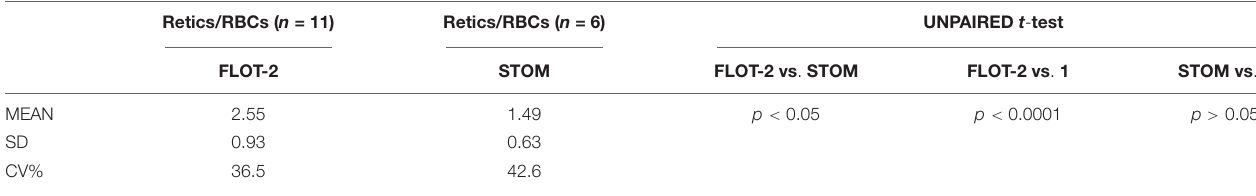
TABLE 2 | Western blotting quantification of the ratio between flotillin-2 and stomatin in Retics and in RBCs normalized over identical amounts of Band 3, as determined by the procedure described in the